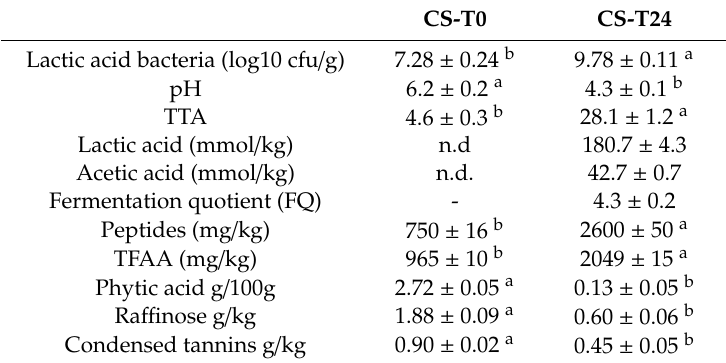
Table 2. Main characteristics of the chickpea sourdough before (CS-T0) and after fermentation (at 30 ◦ C for 24 h, CS-T24) with Lactoplantibacillus plantarum LB1 and Furfurilactobacillus rossiae